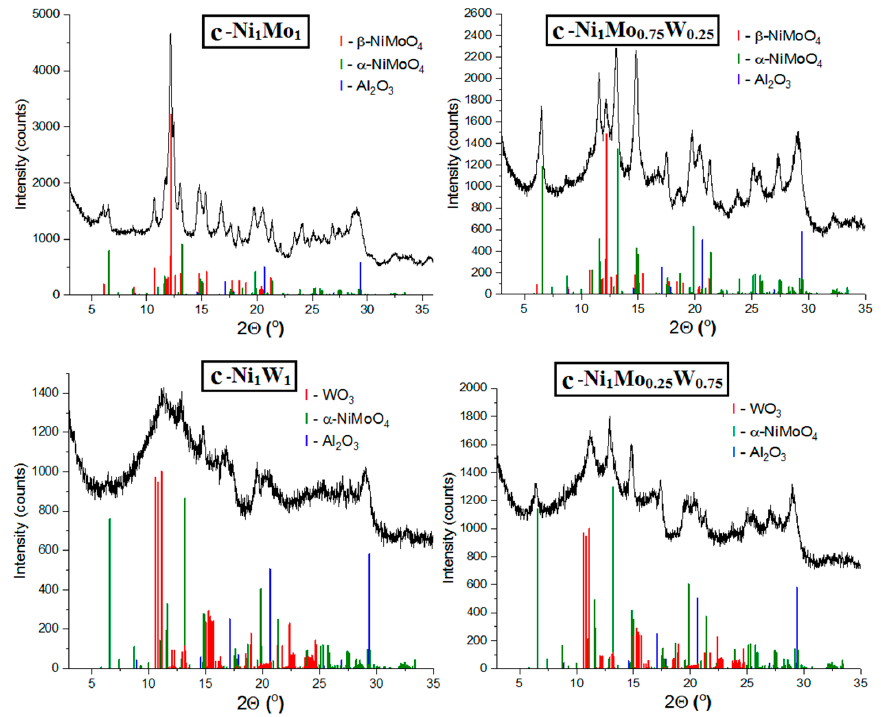
Figure 2. The XRD patterns of catalysts with different metals ratio. The location and relative intensity of the peaks of identified phases are shown.